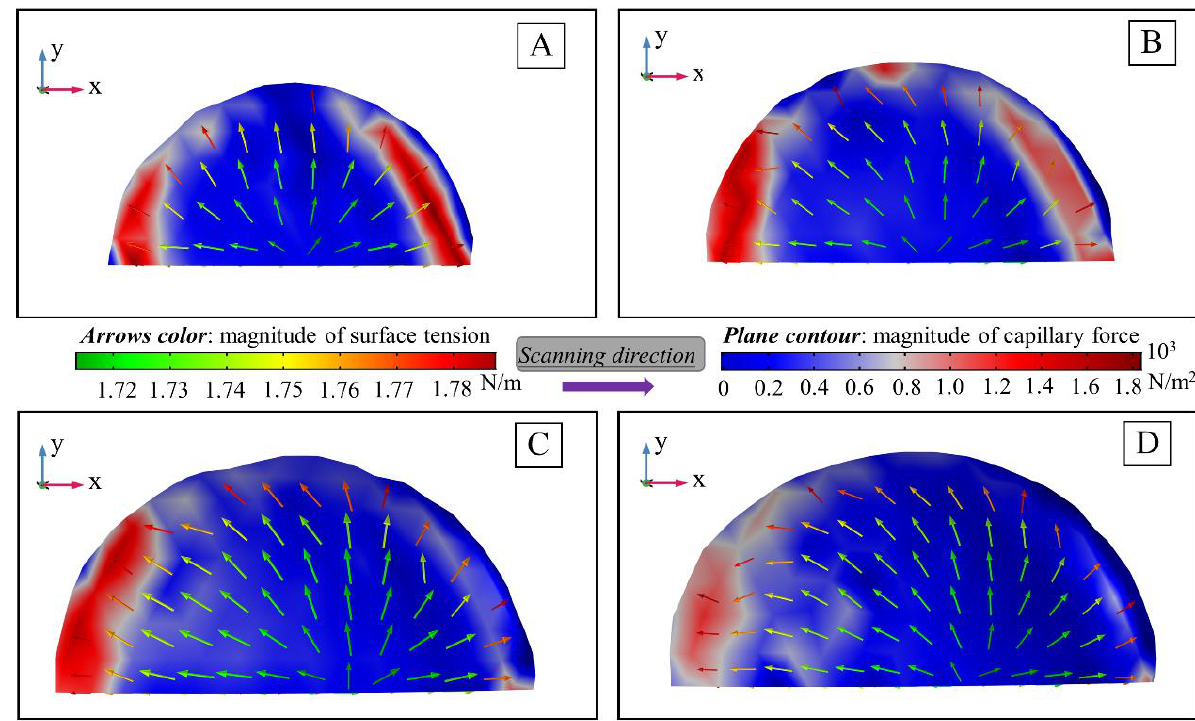
Figure 5. Capillary force distribution at top surface of the melt pool at different times: ( A ) 10 ms; ( B ) 50 ms; ( C ) 100 ms; ( D ) 200 ms.